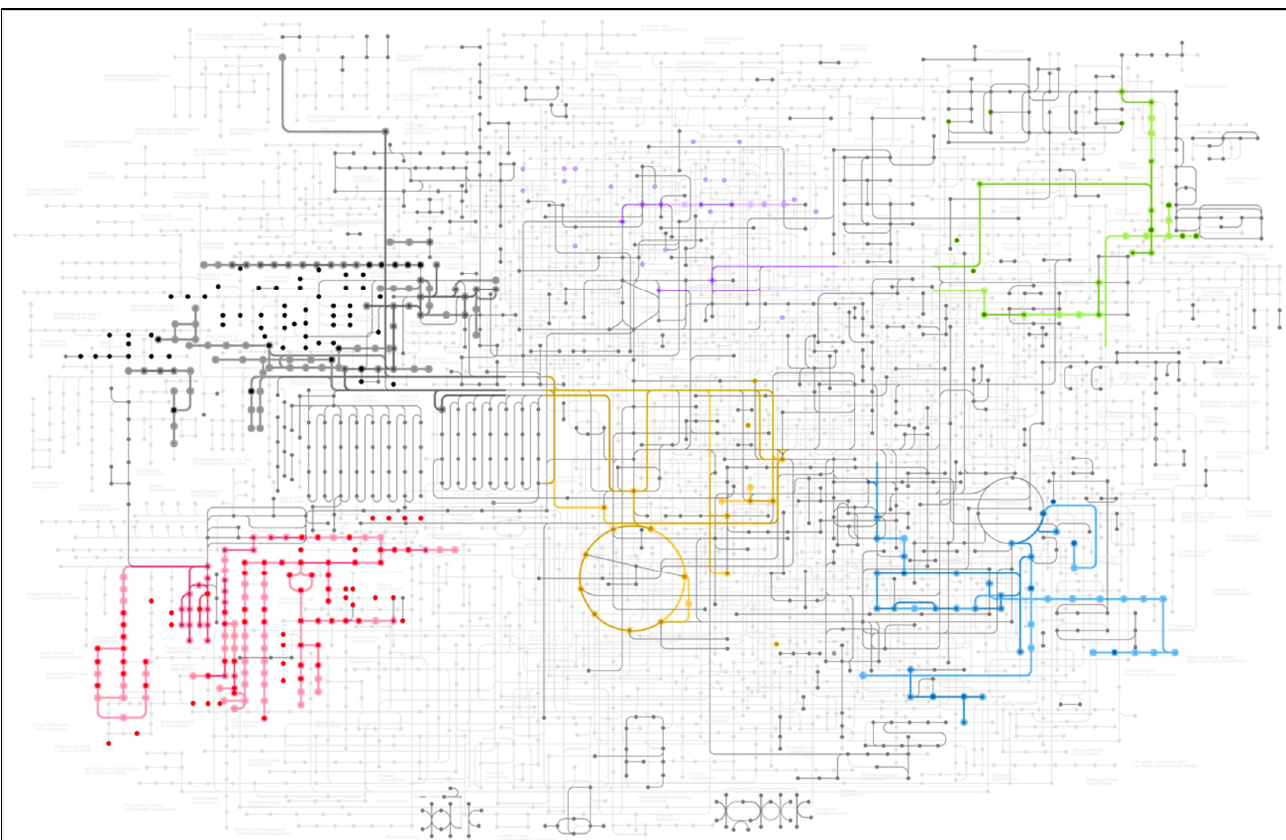
Figure 3. Overview of the KEEG pathways (coloured lines) and putative metabolites (highlighted dots) identified using the MassTRIX, with the Fourier-transform ion cyclotron-resonance aligned mass spectra of the diatom exposed to fluoxetine as a baseline.